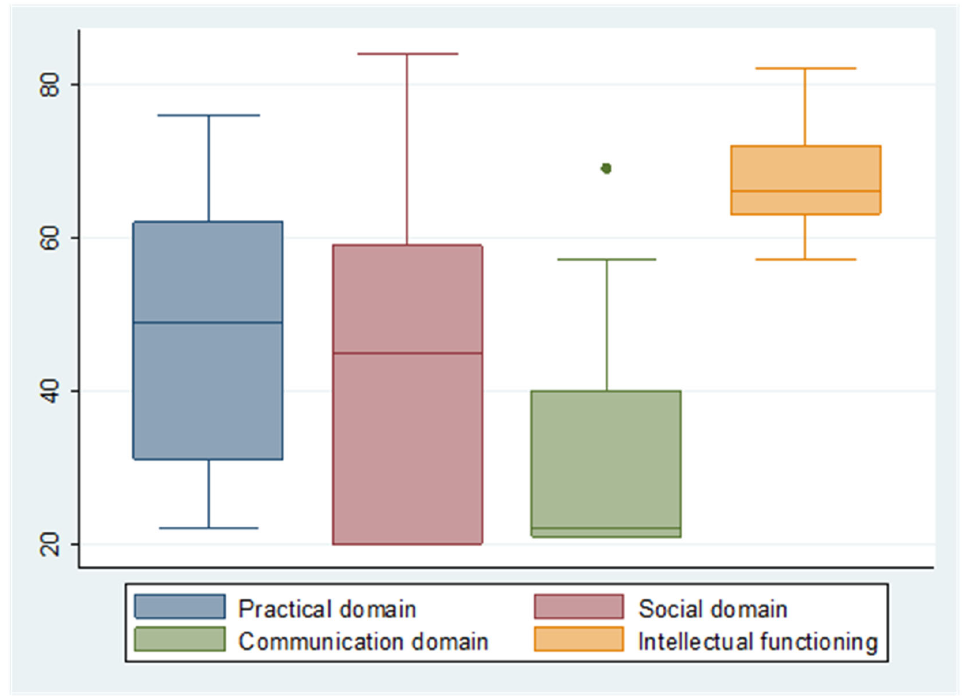
Figure 1. Boxplots of the domains of intellectual disability (standard scores of Vineland ‐ II domains and SON ‐ R 6 ‐ 40).